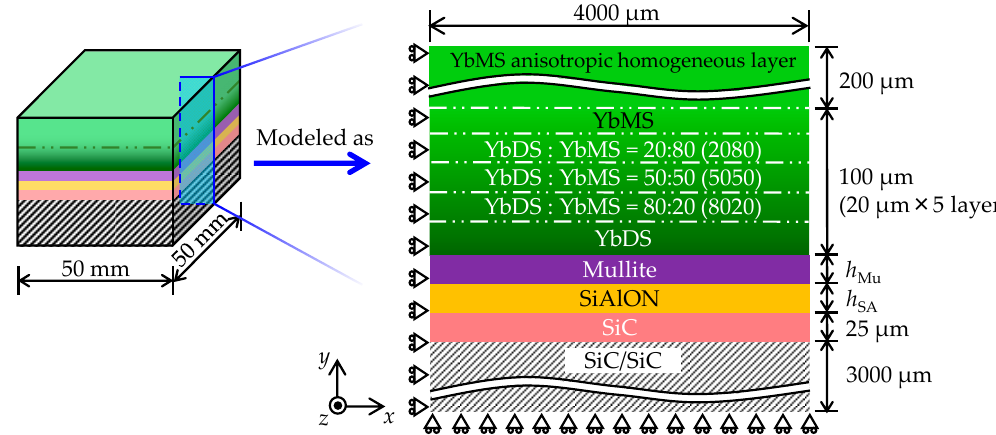
Figure 2. Schematic illustration of finite element method (FEM) analyses model and boundary condition.